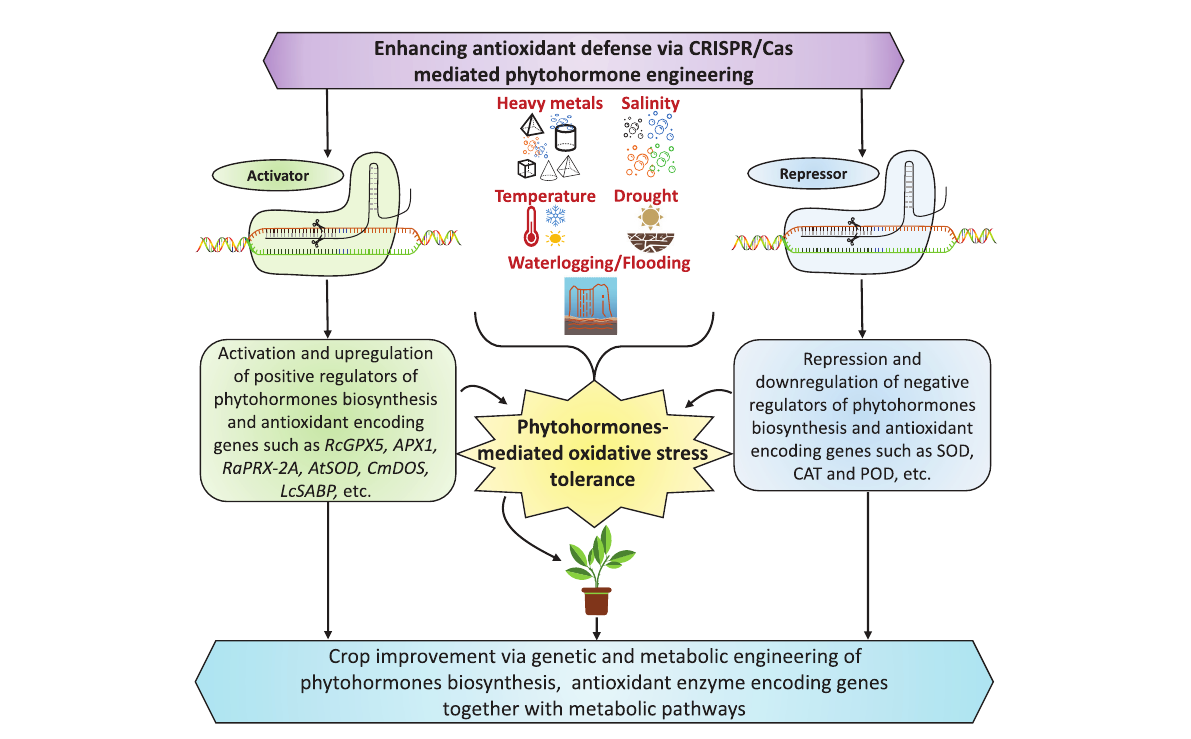
FIGURE5 Schematic for improving phytohormone-mediated antioxidant defense via genetic and metabolic engineering using a modern gene-editing tool such as clustered regularly interspaced short palindromic repeats-CRISPR-associated proteins (CRISPR/Cas). Targeted engineering to activate or repress biosynthesis and enzyme-encoding genes can help enhance abiotic-stress-induced oxidative stress in plants by improving the activity of antioxidant defense systems. The genes within the boxes are based on the literature cited in the main